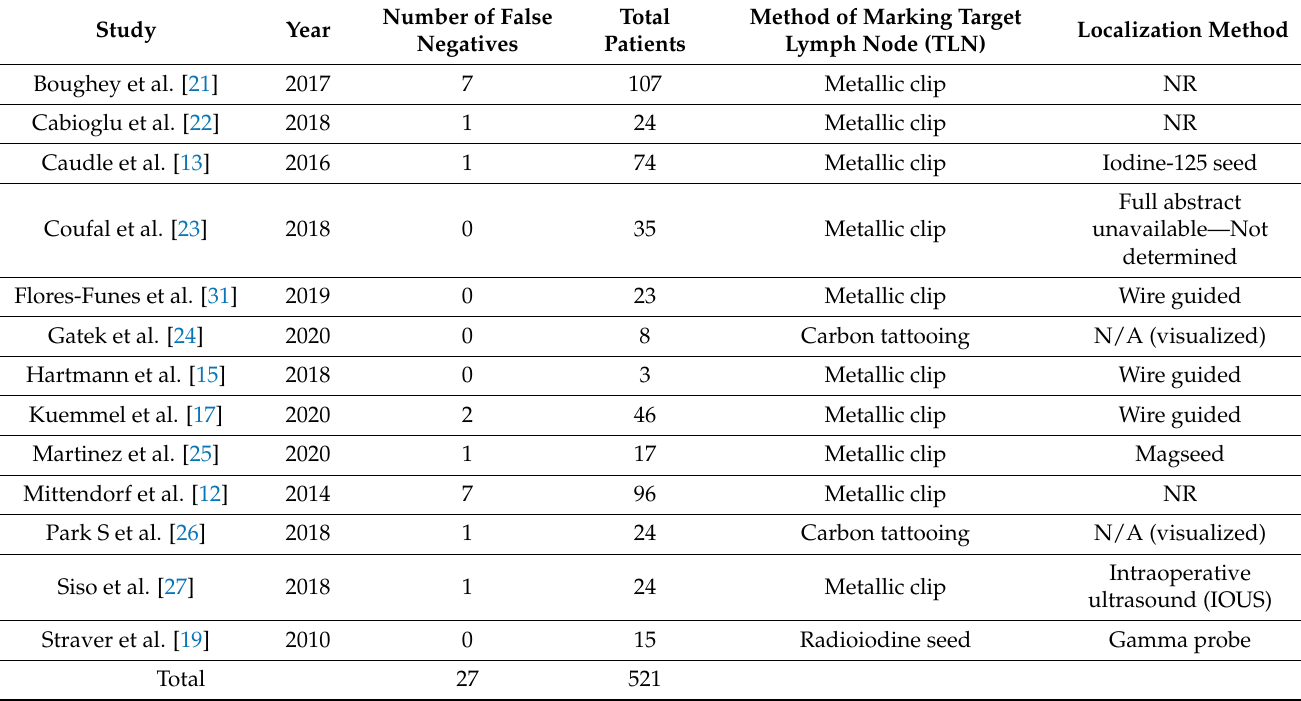
Table 2. Targeted axillary dissection (TAD) (MLNB + sentinel lymph node (SLN)) studies and